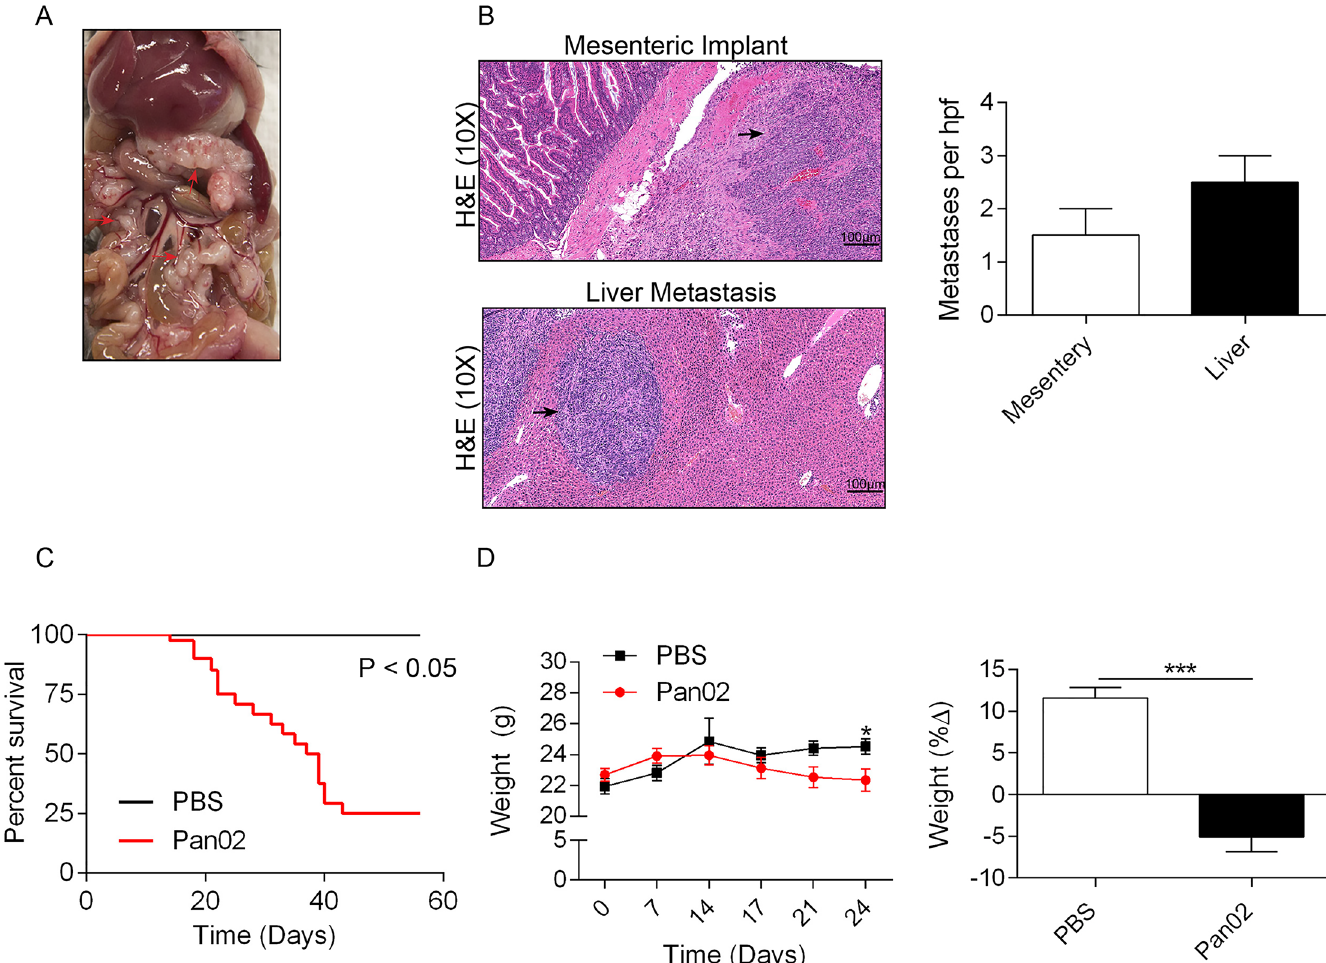
Fig 1. Mice challenged with Pan02 developed lethal tumor burden associated with progressive weight loss. (A) Mice administered Pan02 exhibited gross and (B) microscopic evidence of peritoneal carcinomatosis as well as microscopic liver implants. Representative images and summary data are shown. (C) Kaplan-Meier analysis of survival was performed in PBS and Pan02 treated animals (n = 20/group, p < 0.05). (D) The average body weights of mouse cohorts treated with PBS or Pan02 were calculated at various time points as was the total weight change over the course of the study (n = 20; * p < 0.05, *** p <